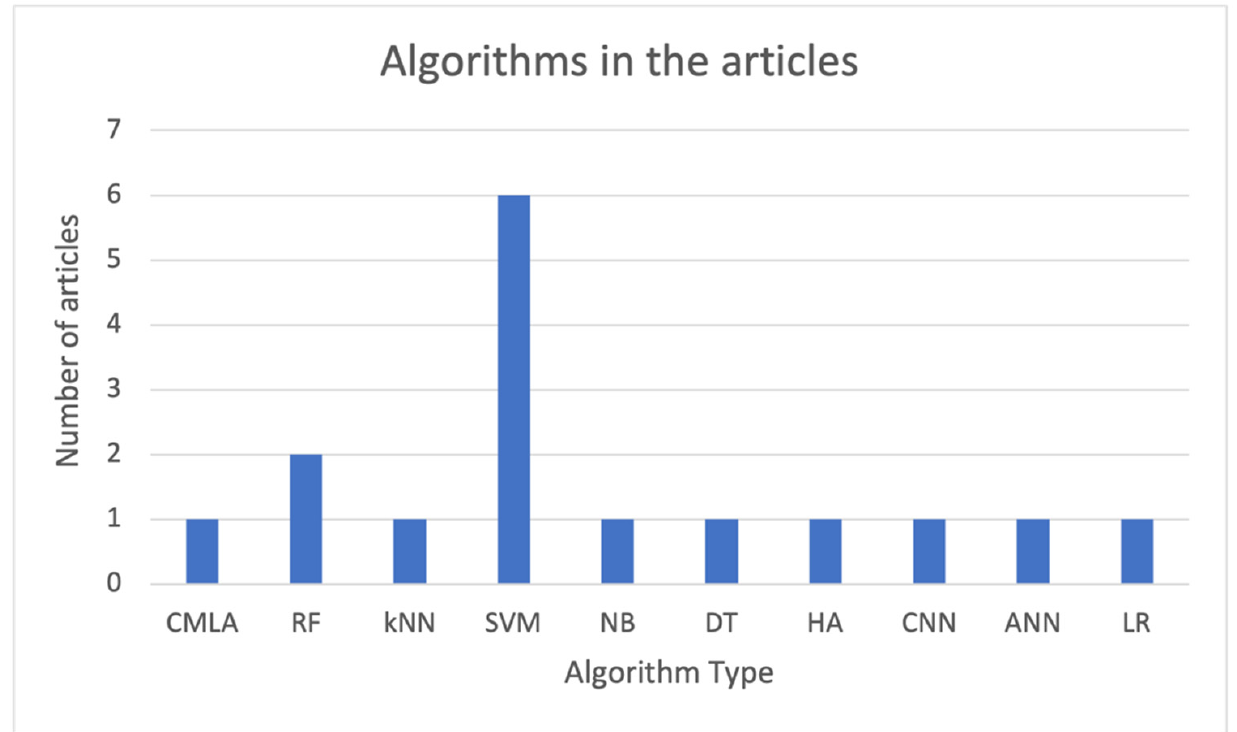
Figure 3. Diagram bar with the type of algorithms utilized. Acronyms: SVM—support vector machines; KNN—k-nearest neighbors; DT—decision tree; CNN—convolutional neural network; RF—random forest; LR—linear regression; NB—näive Bayes; HA—hierarchical algorithm; ANN—artificial neural network; CMLA—customized machine learning algorithm.